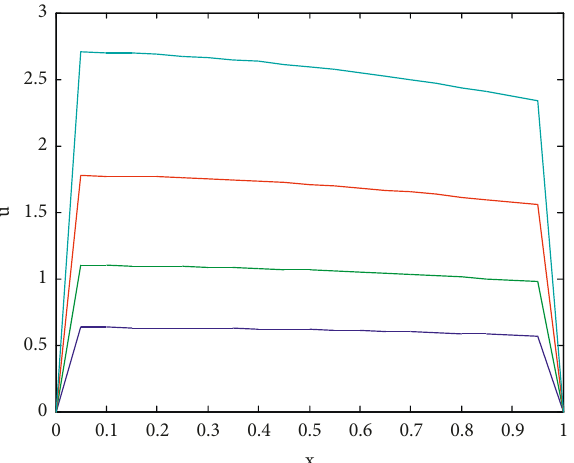
Figure 3: The behavior of spatial vs solution graph with different time level for Example 2 for m � 20, n � 20, and ε � 10 − 10